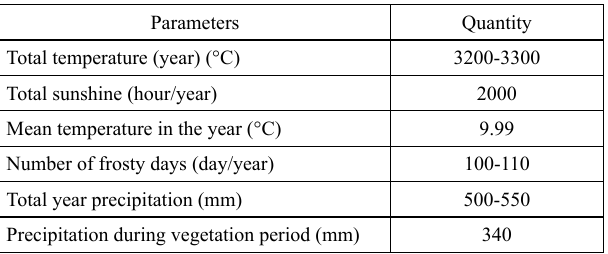
Table 1. Meteorological data of the research field in Debrecen-Pallag (2013)